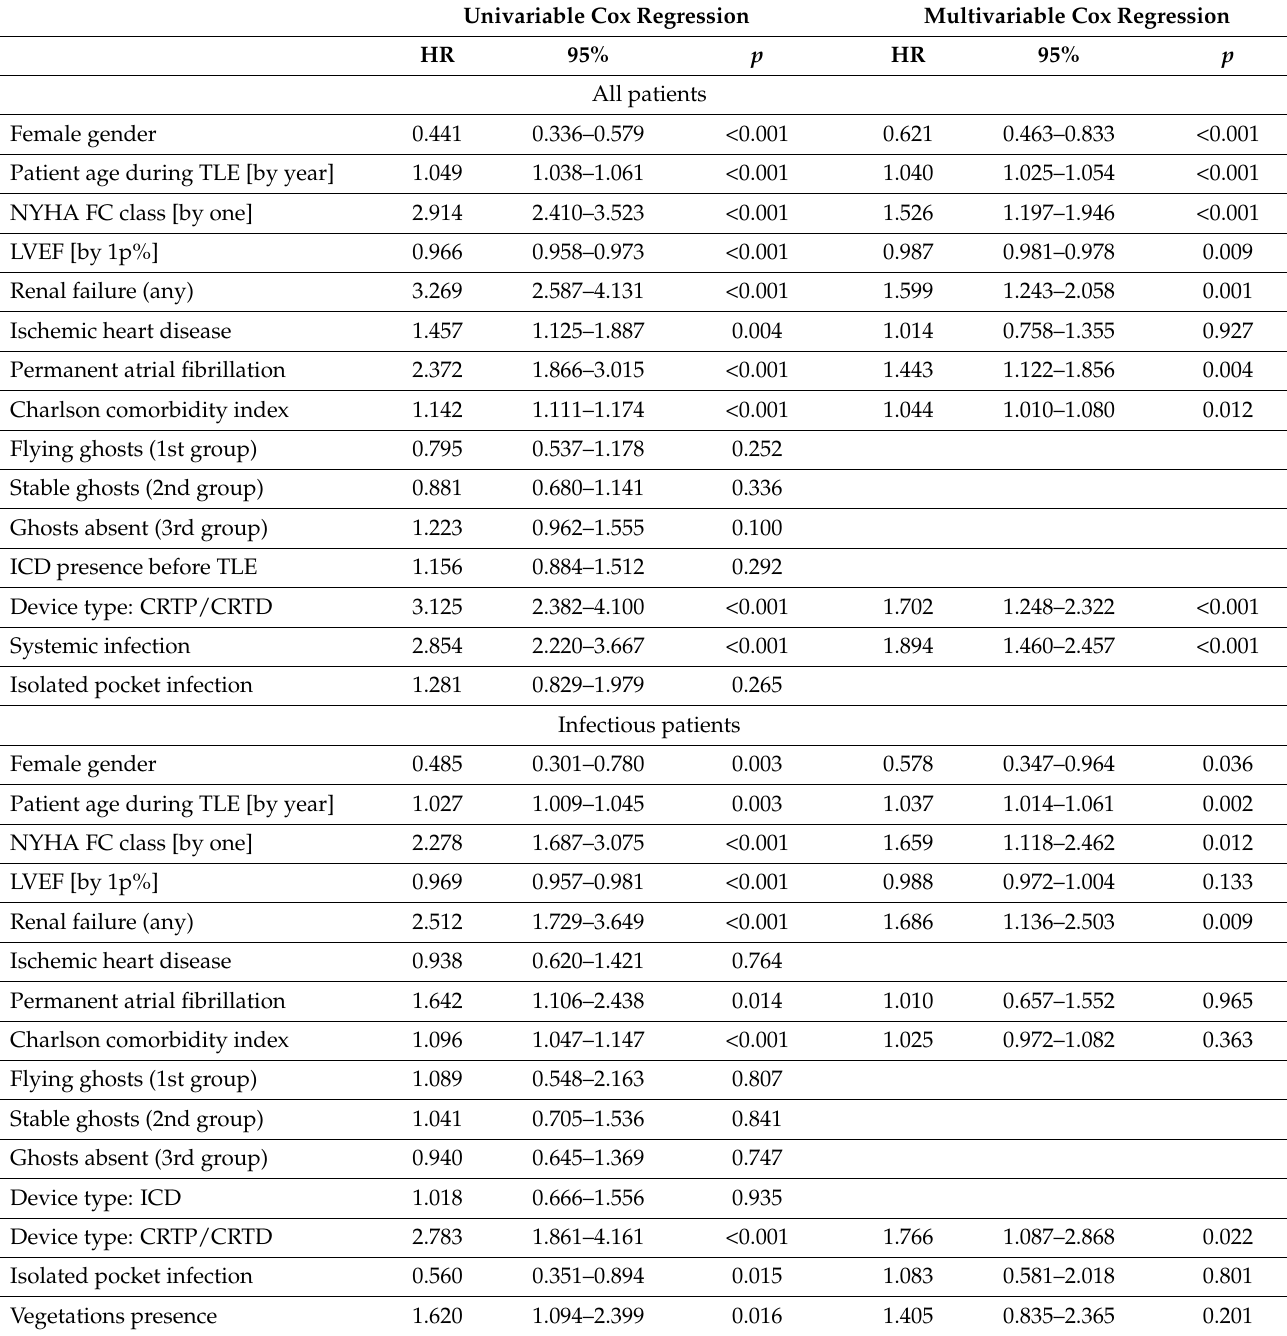
Table 4. Factors influencing long-term prognosis after TLE, results of uni- and multivariable Cox regression